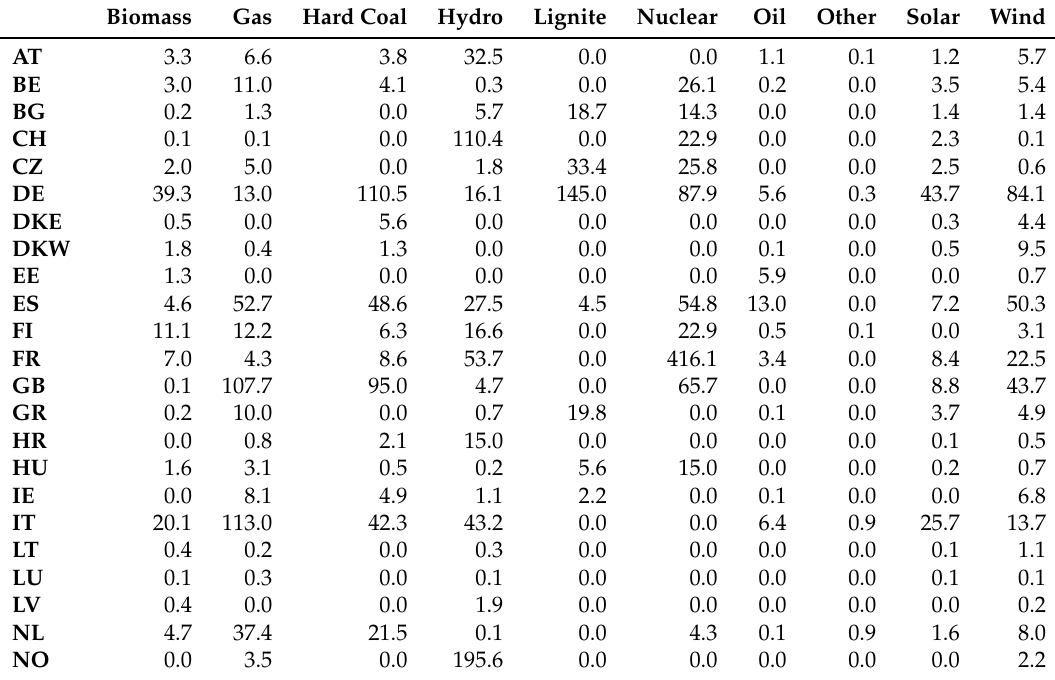
Table A5. Electricity generation